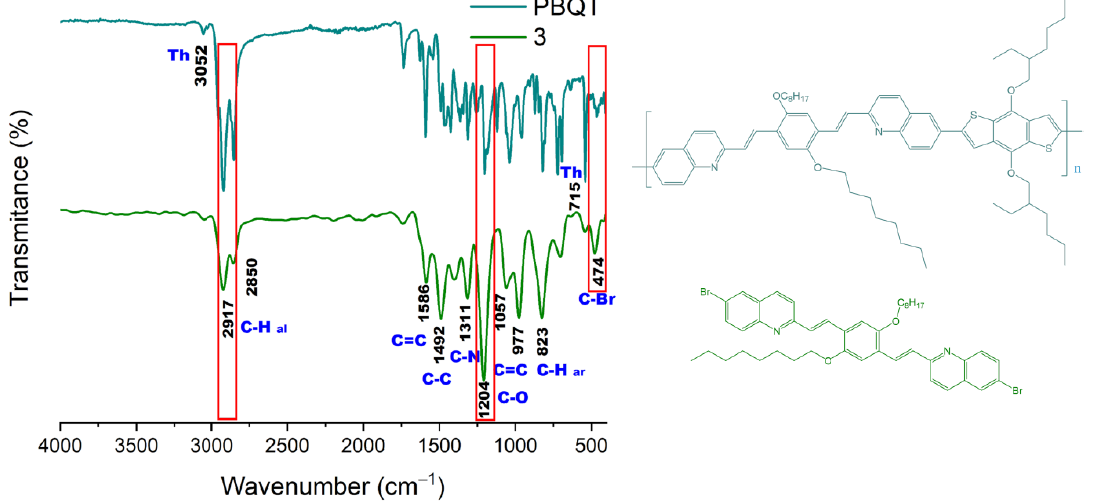
Figure 2. Comparative FTIR spectra of compound 3 and PBQT in thin film from CHCl 3 solutions.